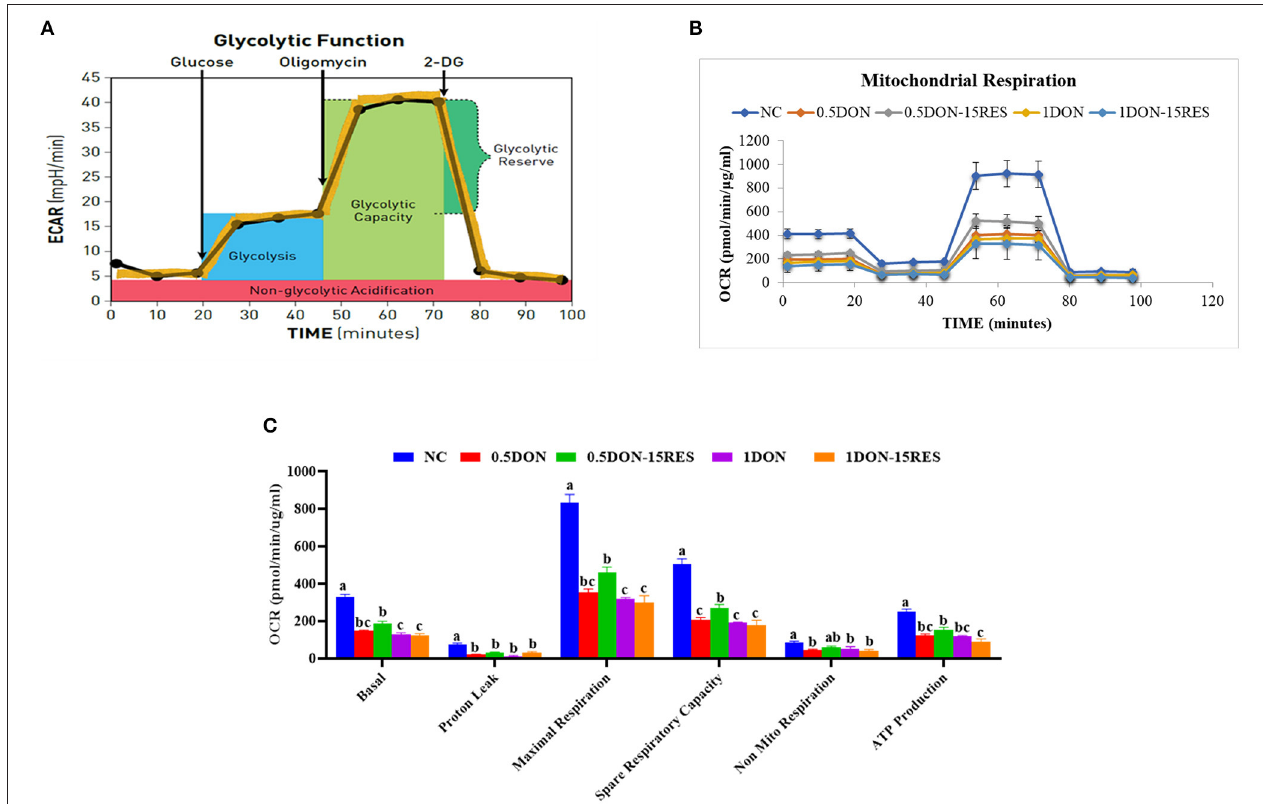
FIGURE 4 | RES improved the negative effect on mitochondrial respiration by DON in vitro . (A) Schematic and (B) oxygen consumption rate (OCR) assessed by extracellular flux analysis. OCR was measured under basal conditions followed by the sequential addition of oligomycin (0.5 µ M), FCCP (1 µ M), rotenone (1 µ M), or antimycin A (1 µ M). Each data point represents an OCR measurement. (C) Individual parameters for basal respiration, proton leak, maximal respiration, spare respiratory capacity, nonmitochondrial respiration, and ATP production were determined. Cells were treated with 0 (NC) or 0.5 µ mol/L or 1 µ mol/L DON and 0 or 15 µ M RES, respectively. Data were expressed as means ± SEM of at least three independent experiments. (A–C) Values with different letters are significantly different ( P < 0.05).